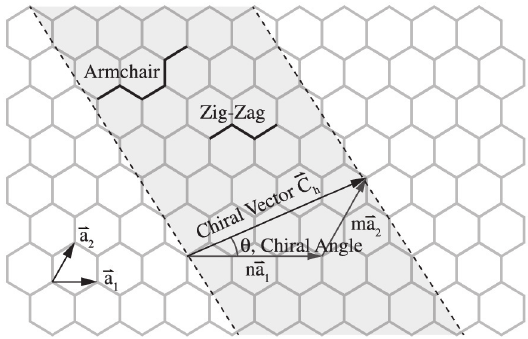
Figure 1. Schematic representation of rolling graphene layer to create CNT 15 .